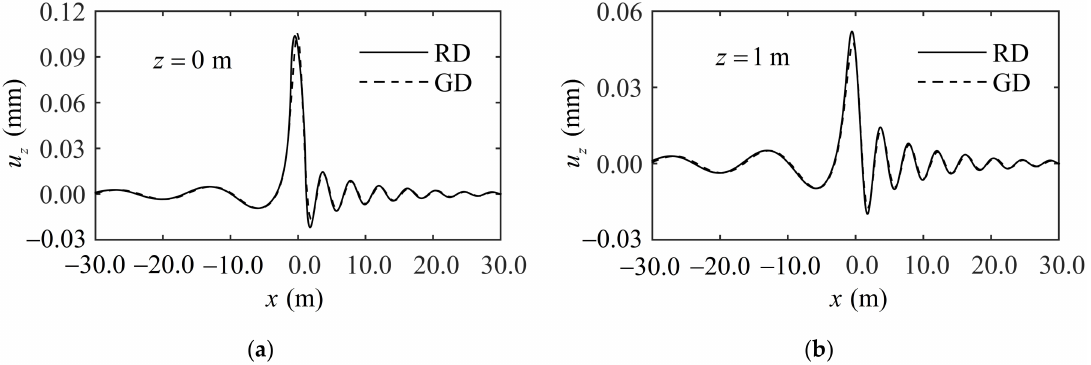
Figure 7. Comparison of displacement for the RD and GD at ( a ) interface z = 0 m and ( b ) interface z = 1 m.